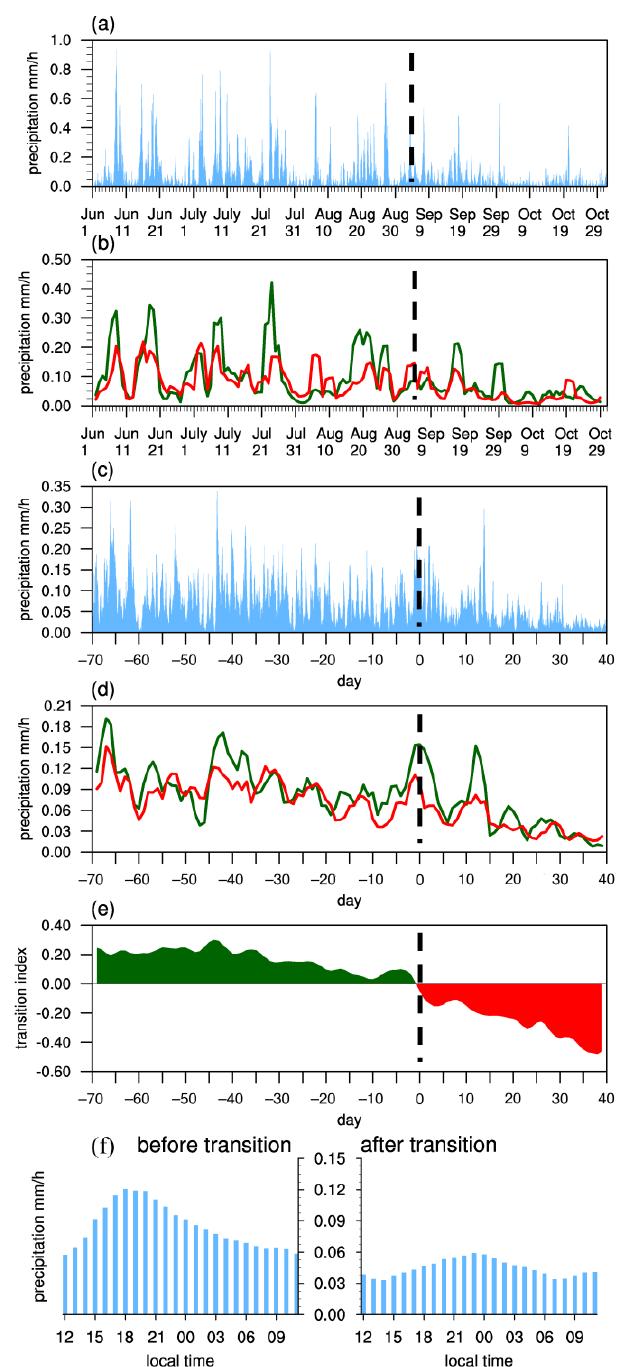
Figure 2. ( a ) Hourly domain (white box in Figure 1a) averaged precipitation (mm/h) for 2013 June–October, ( b ) nighttime (20:00–08:00, dark green line) and daytime (08:00–20:00, red line) precipitation for 2013 June–October, ( c ) composite analysis (2010–2015) of hourly domain averaged precipitation (mm / h) from day − 70 to 40 relative to transition date, ( d ) same as ( b ) but for the composite (2010–2015) daily domain averaged nighttime and daytime precipitation (mm / h); ( e ) composite (2010–2015) transition index (TI) anomalies using a 3-day running mean, and ( f ) composite (2010–2015) hourly domain averaged precipitation (mm / h) before and after transition. The black dashed lines in ( a , b ) indicate transition date 4 September 2013, while black dashed lines in ( c – e ) indicate composite transition